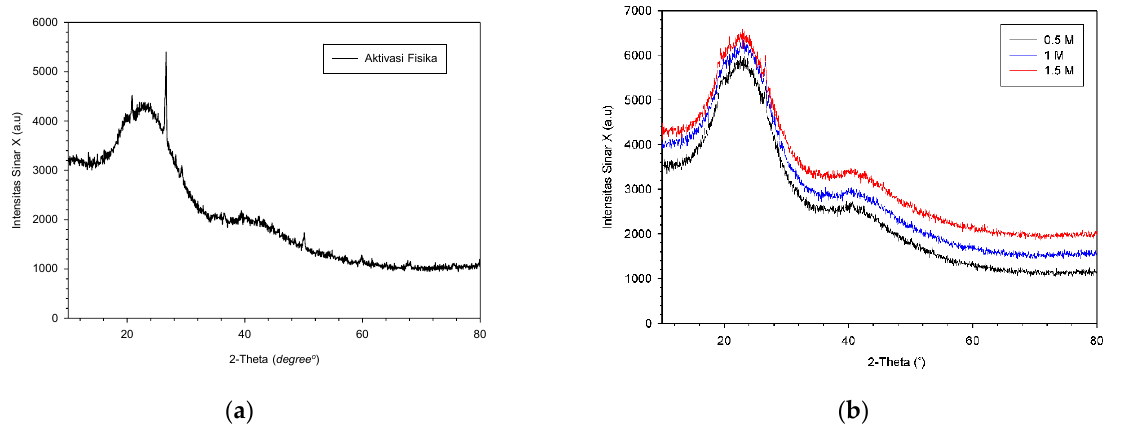
Figure 5. Diffractogram XRD of ( a ) unmodified membrane adsorber without HCL activation (AC); ( b ) activated adsorber membrane using g 0.5 (H1), 1 (H2), 1.5 (H3) M HCl.